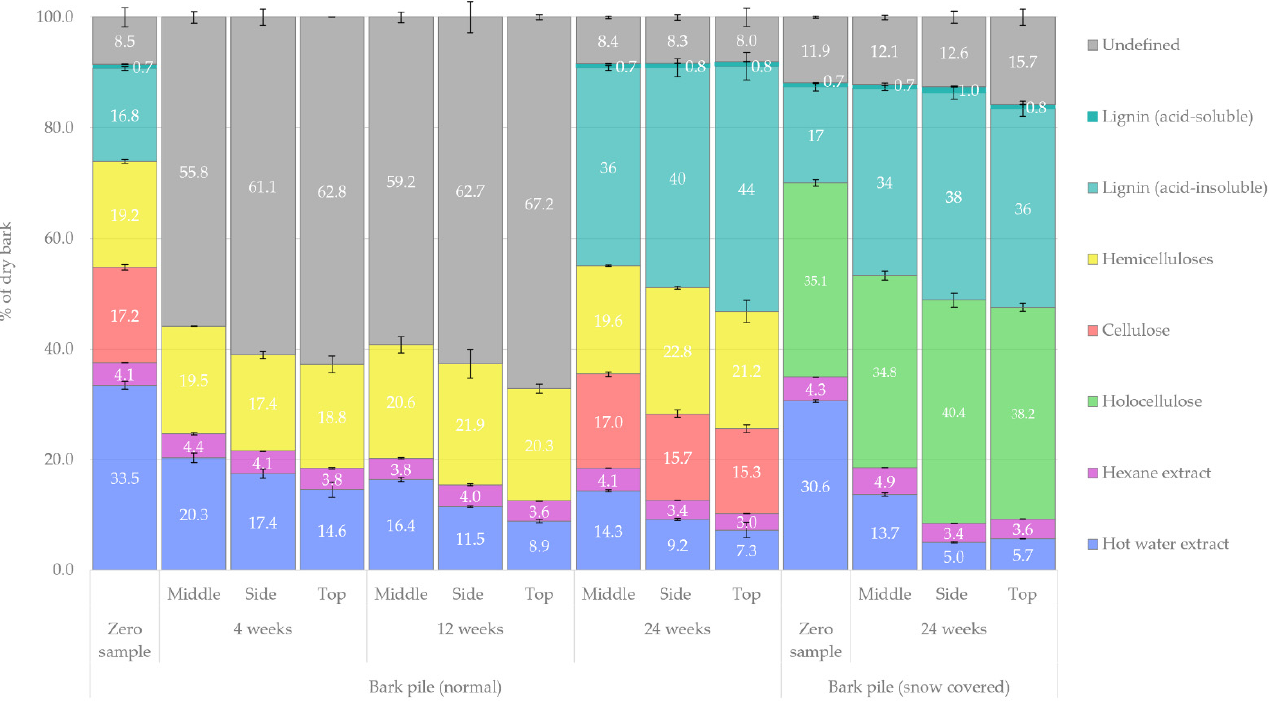
Figure 1. Overall changes in the bark samples’ chemical composition during storage as % of dry bark.